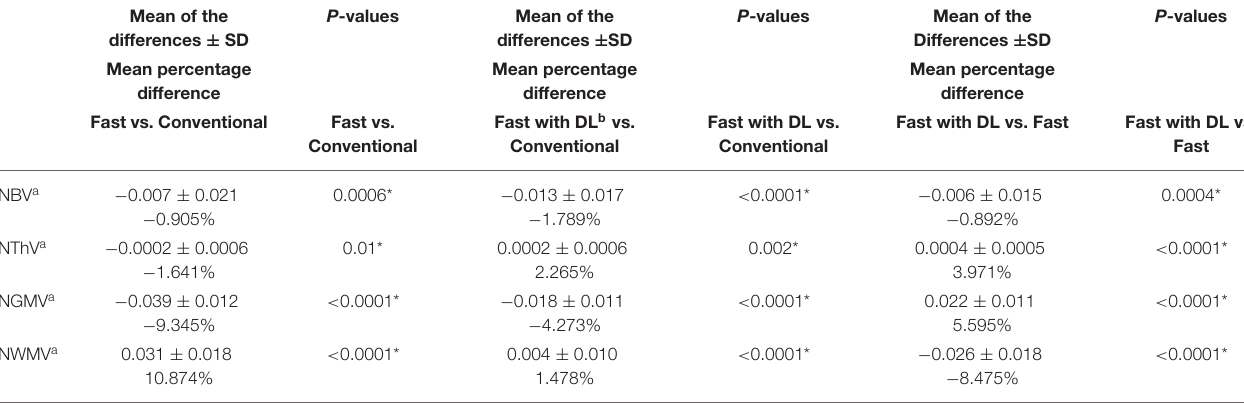
TABLE 2 | Paired differences for T1w volume measures across methods. P -values Mean of the Mean of the differences ± SD differences ± SD